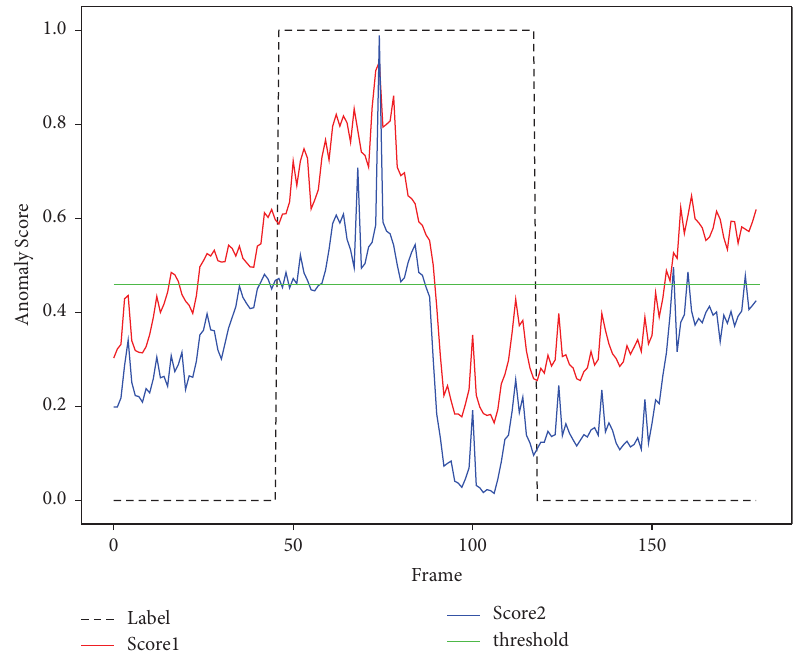
Figure 9: Anomaly scores on the Avenue testing